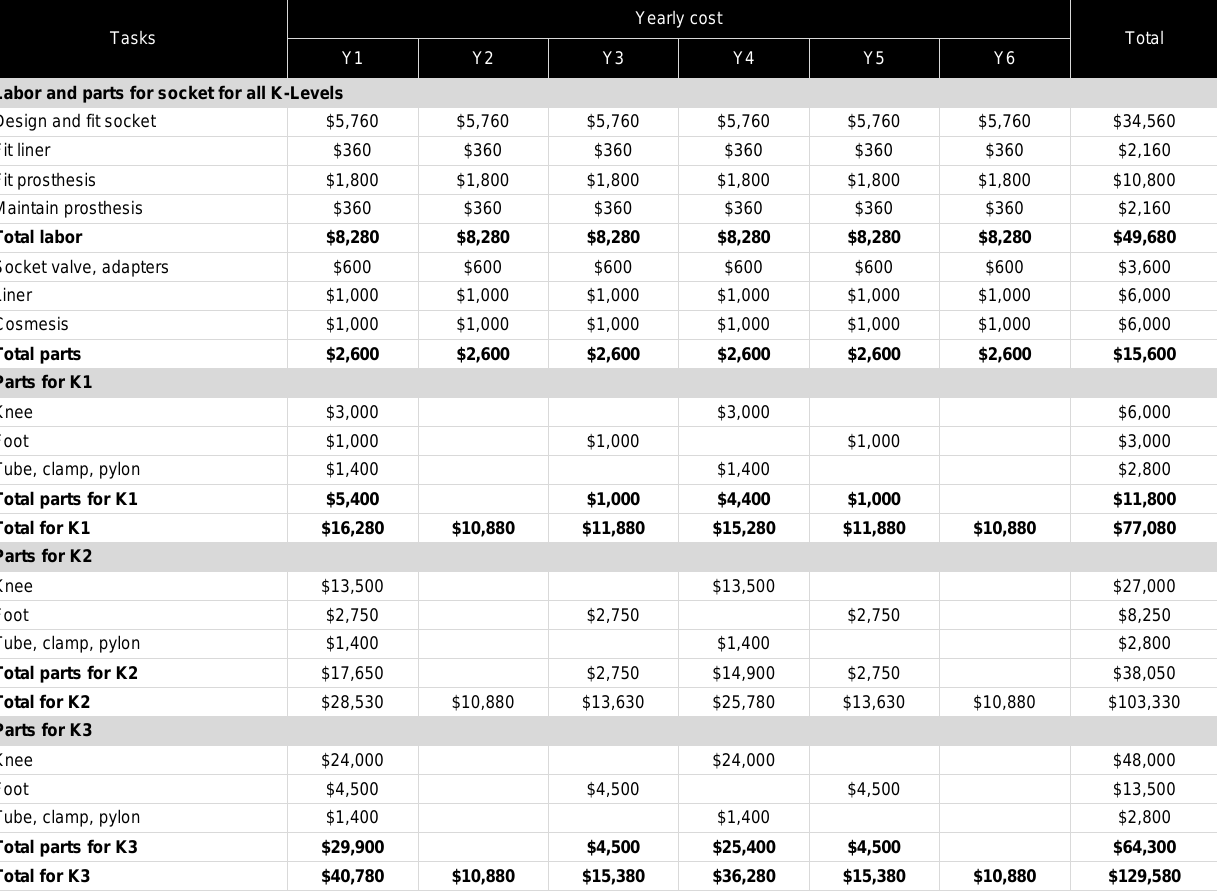
Table 4: Overview of total costs, utilities, incremental cost-utility ratio (ICUR) and differences between ICUR and willingness-to-pay threshold (WTP=$40,000 per QALY) for yearly provision of two and one sockets fitted transfemoral prostheses attached to residuum without (USU)